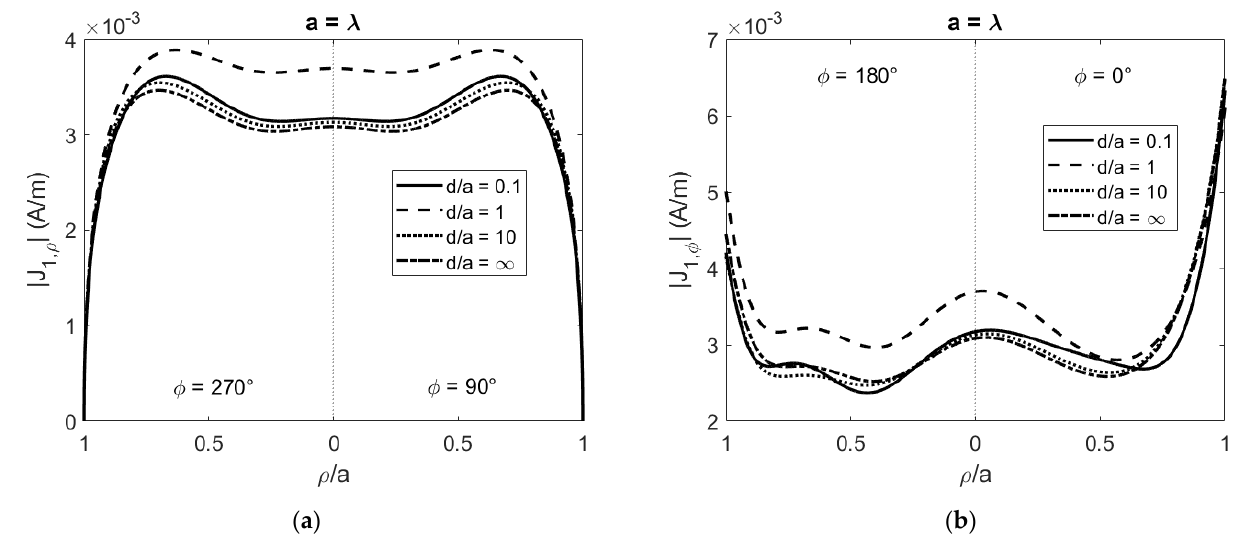
( a ) ( b ) Figure 4. Components of the effective electric current densities on the upper disk (disk 1) of a two stacked thin resistive Figure 4. Components of the effective electric current densities on the upper disk (disk 1) of a two stacked thin resistive disks resonator for different values of the distance between the disks ( disks resonator for different values of the distance between the disks ( d / a = 0.1,1,10, ∞ ). a = λ , R 1 = 100 Ω , R 2 = 200 Ω , (cid:12) (cid:12) (cid:12) = 30 ◦ , φ = 0 ◦ , and TE incidence: ( a ) (cid:12) (cid:12) J | E | = 1 V/m, θ (cid:12) ; ( b ) (cid:12) J 1, φ (cid:12) 0 0 1, ρ 0